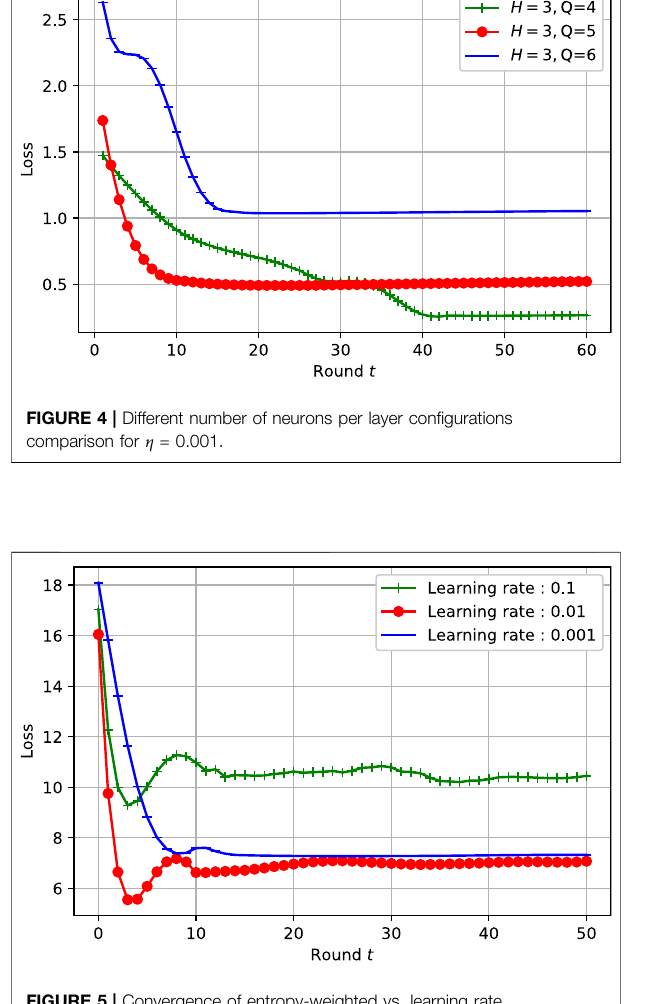
FIGURE 5 | Convergence of entropy-weighted vs. learning rate.